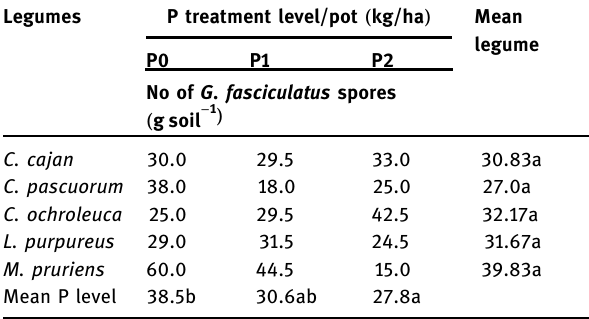
Table 6: E ff ect of phosphorus levels and studied legume species on spores of G. fasciculatus